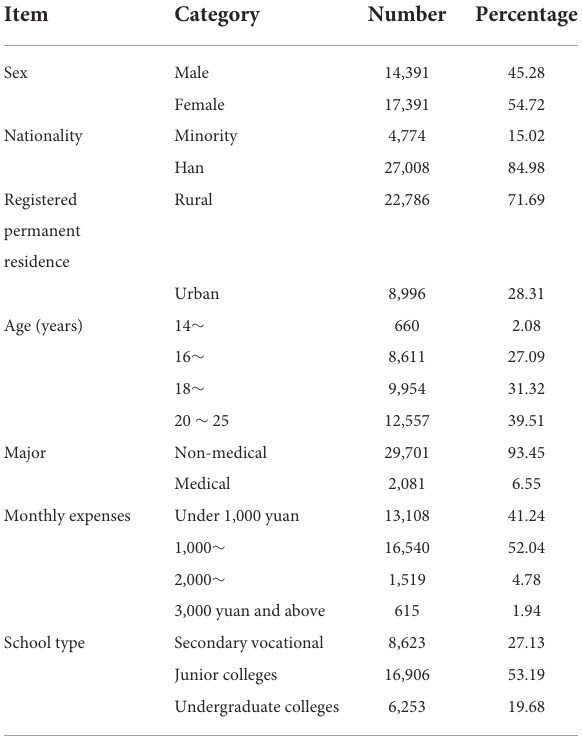
TABLE 1 Demographic data of young students ( n = 31,782).